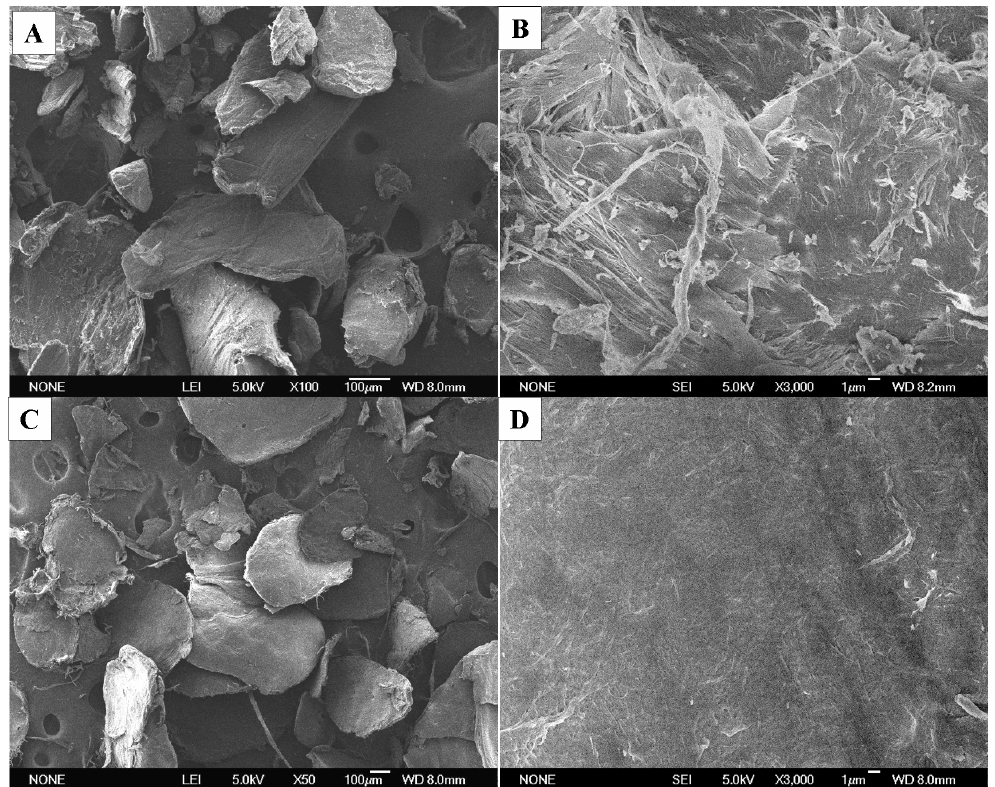
Figure 3. SEM micrographs for  -chitin from shrimp at 50× magnification ( A ) and at 3,000× magnification ( B ) and from adult H. parallela at 50× magnification ( C ) and at 3,000× magnification ( D